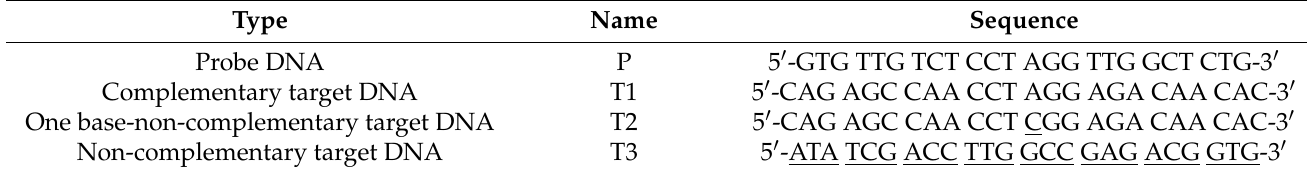
Table 1. Probe and target nucleotide sequences. The bases leading to the mismatches are underlined.